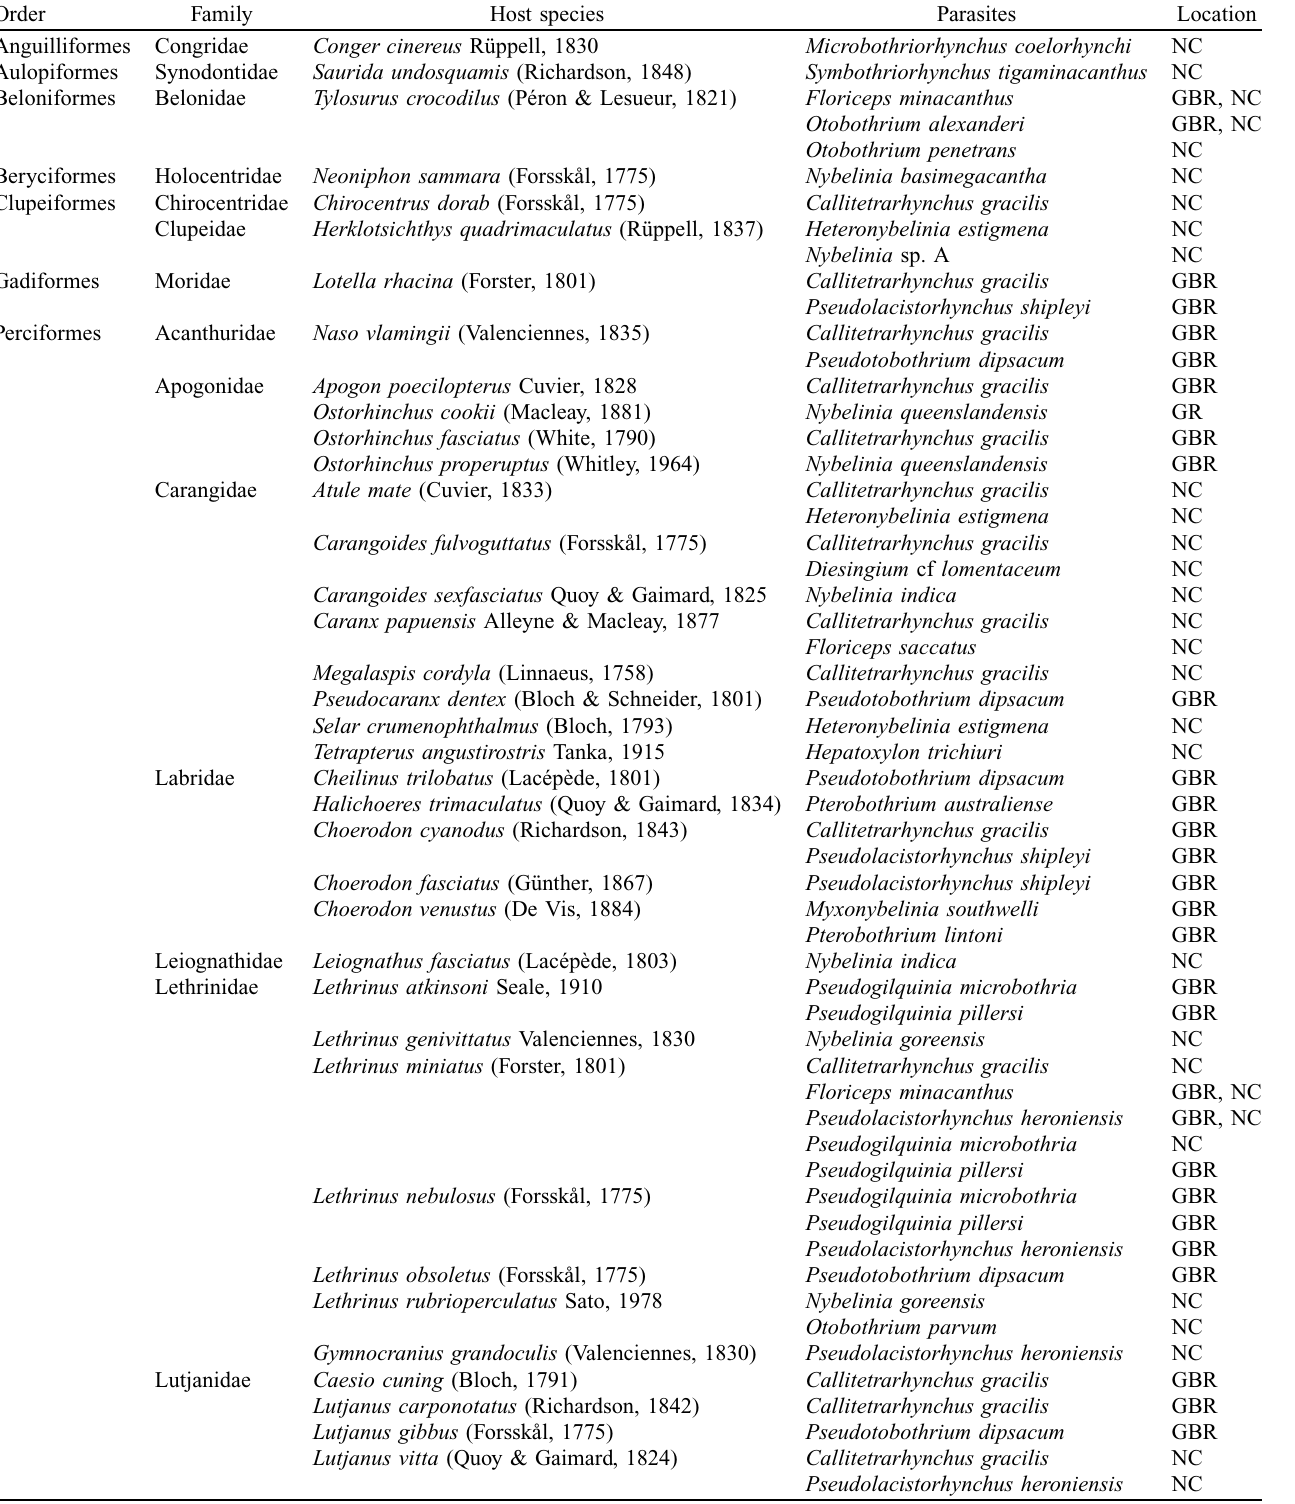
Table 2. Species of trypanorhynch cestodes collected from teleosts on the Great Barrier Reef, Australia and from New Caledonia. Authorities of fish are included and cestodes are listed in alphabetical order without authorities. GBR: Great Barrier Reef; NC: New Caledonia.